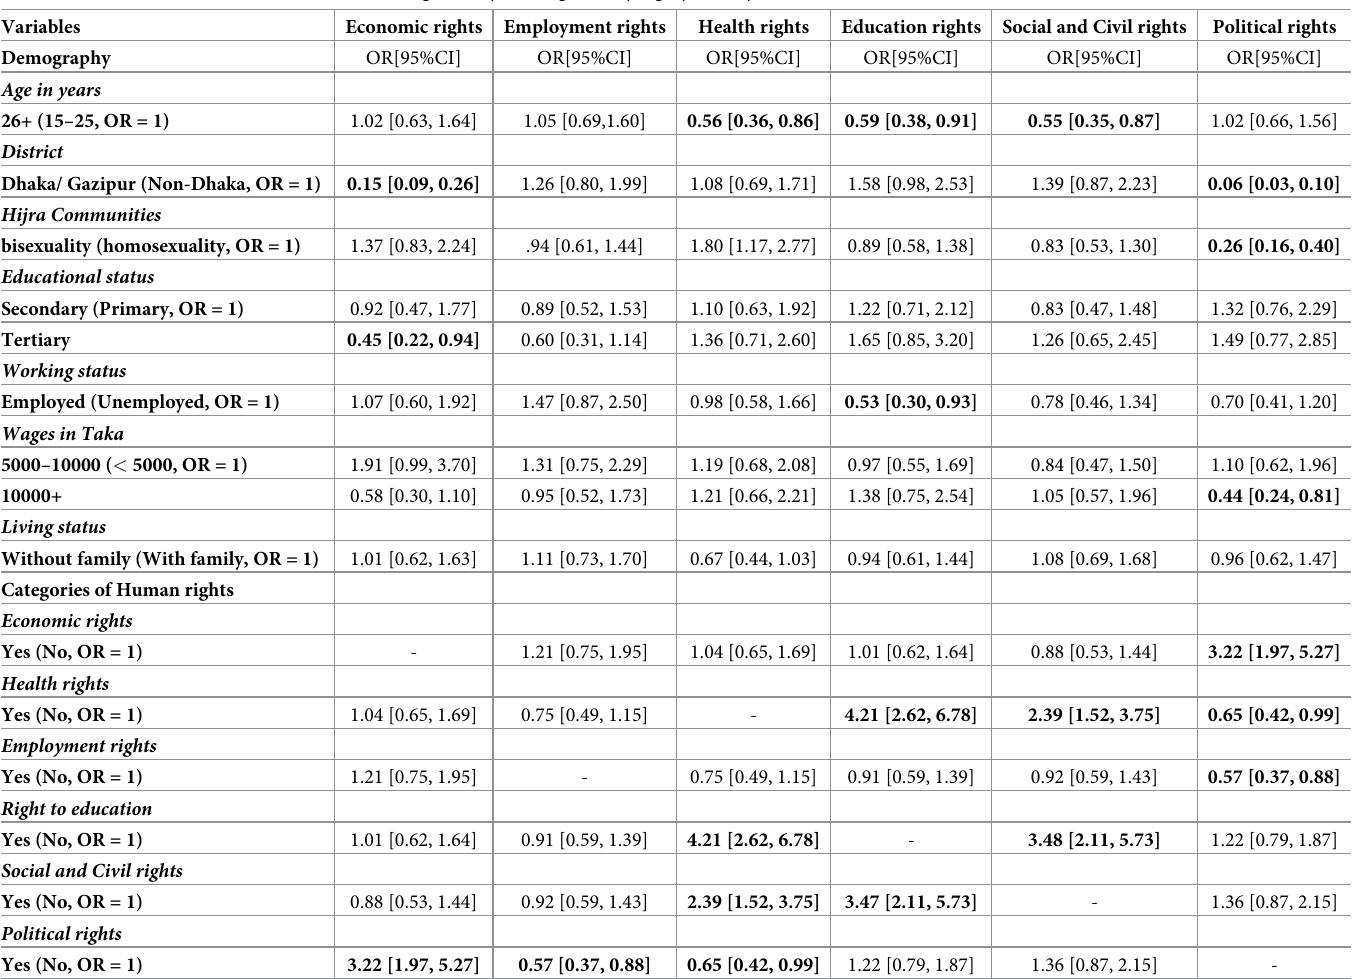
Table 3. Simple logistic analysis of six human rights violations in the Bangladeshi Hijras. Odds ratios (OR) and 95% Confidence Intervals (CI). Confidence Intervals (CI) that exclude 1.00 are statistically significant at p < 0.05 level and were bolded. Empty cells represent the human rights category that wasused as anoutcome variable for that model. The non-Dhaka districts included:Chattogram, Mymensingh, Narayanganj and Rajshahi